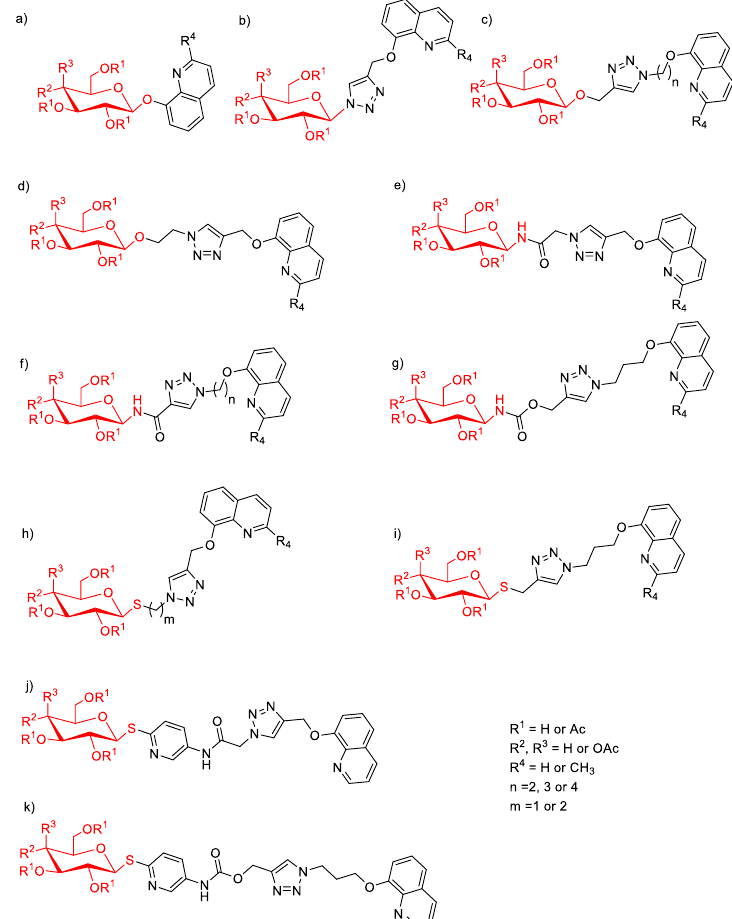
Figure 9. 8-Hydroxyquinoline glycoconjugates containing a 1,2,3-triazole ring in the linker structure ( a – k ).